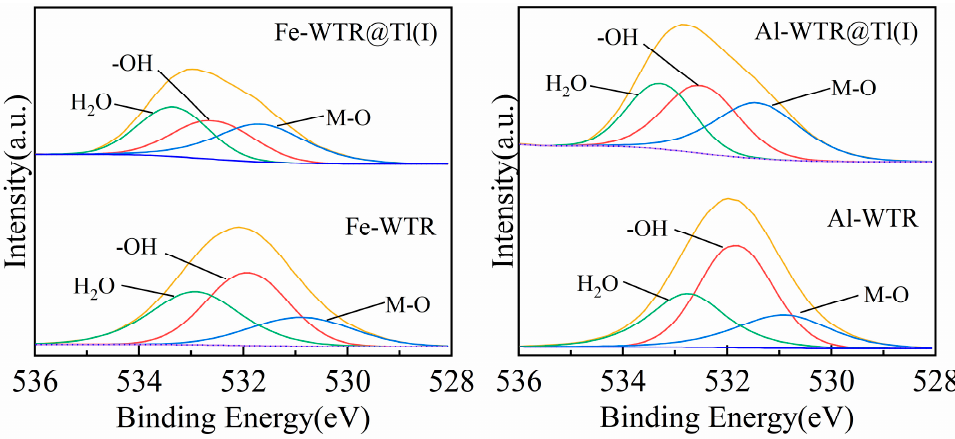
Figure 11. O 1 s spectra of Al-WTR and Fe-WTR before and after adsorption.